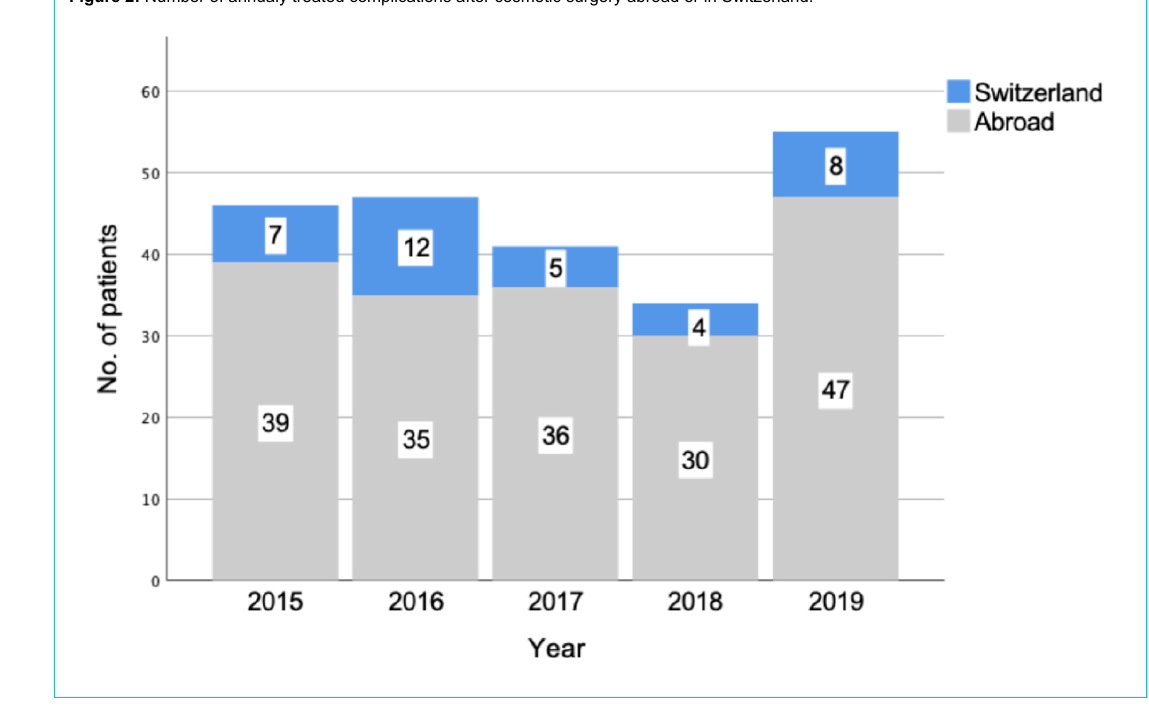
Figure 2: Number of annualy treated complications after cosmetic surgery abroad or in